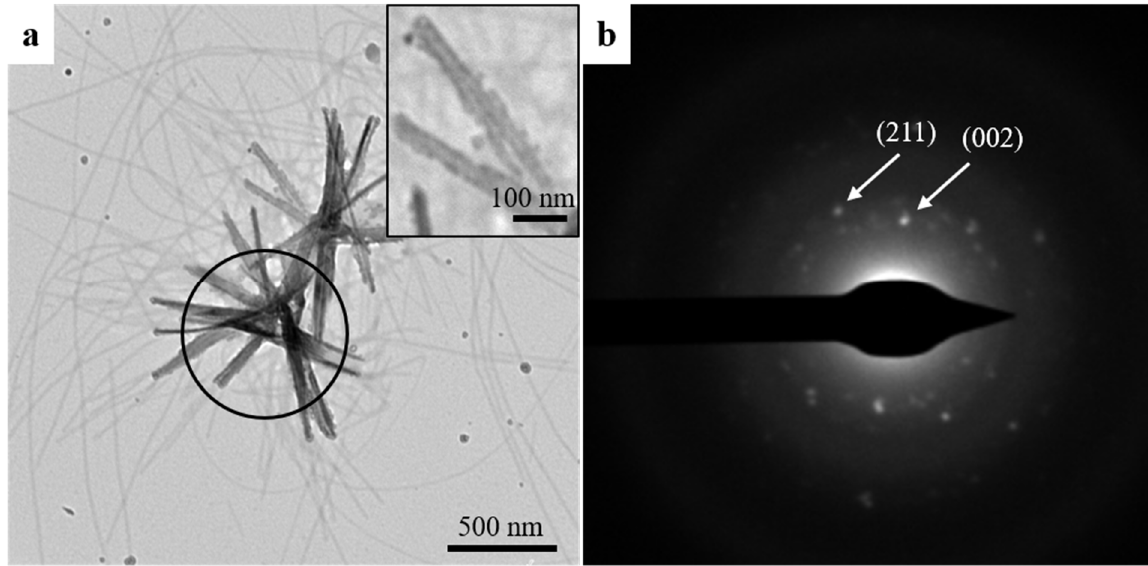
Figure 4. ( a ) Bright-field TEM image of hydroxyapatite organized along NA nanoribbons. ( b ) SAED pattern indicates characteristic crystallographic planes (211) and (002) for hydroxyapatite.